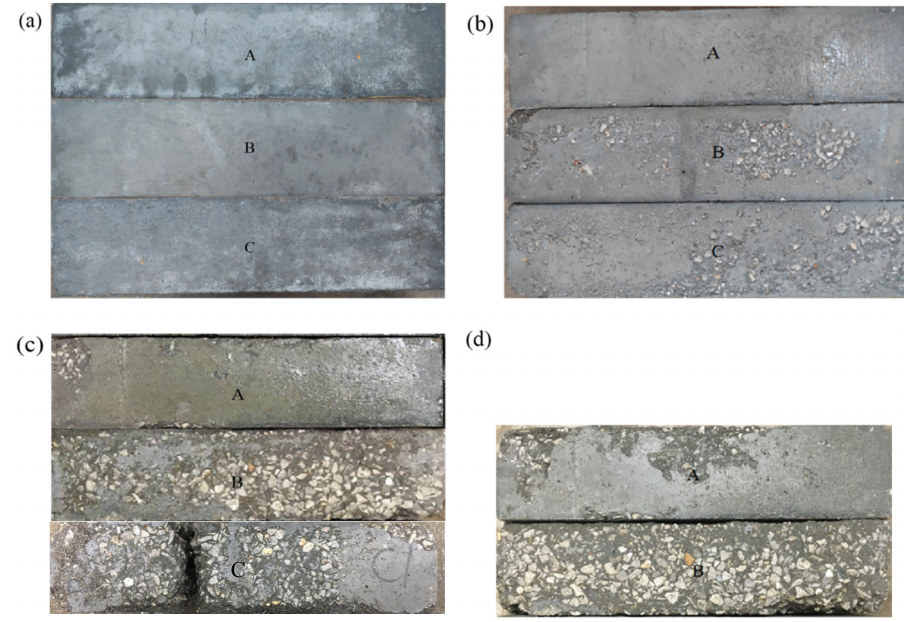
Figure 2. Concrete morphology: ( a ) 0; ( b ) 100; ( c ) 200; and ( d ) 300 salt freezing–thawing